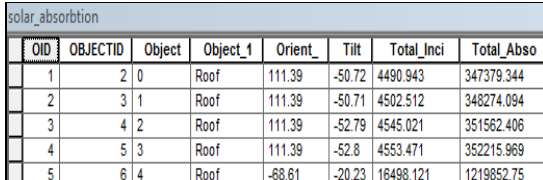
Figure 6. Solar absorb by Palace of Justice building